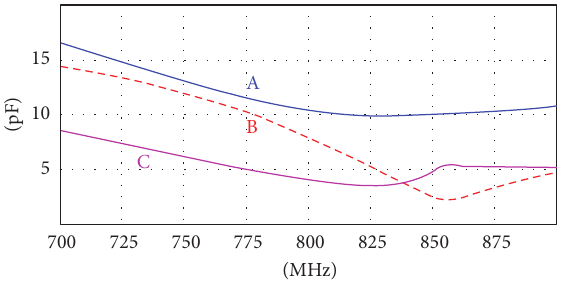
Figure 9: Nominal capacitances of the adjustable impedance devices which realize C 𝑈 in the lossy MAPMUP antenna tuner of Section 5, versus the tuning frequency: 𝐶 𝑈𝐺 is curve A; 𝐶 𝑈𝑁 is curve B; and 𝐶 𝑈𝐹 is curve C.